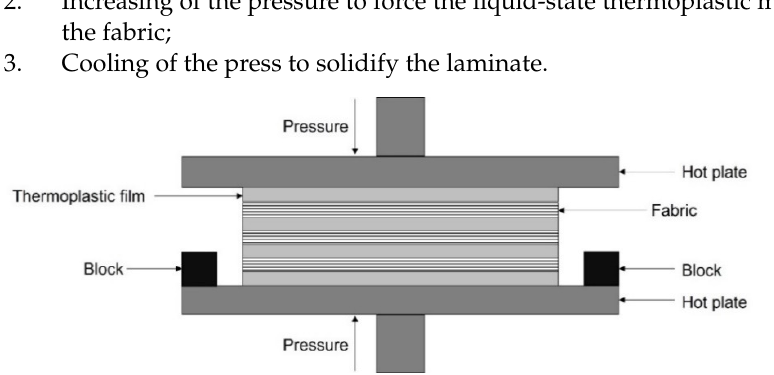
Figure 4. Schematic of film stacking process for thermoplastic composite laminates. Author’s own figure.